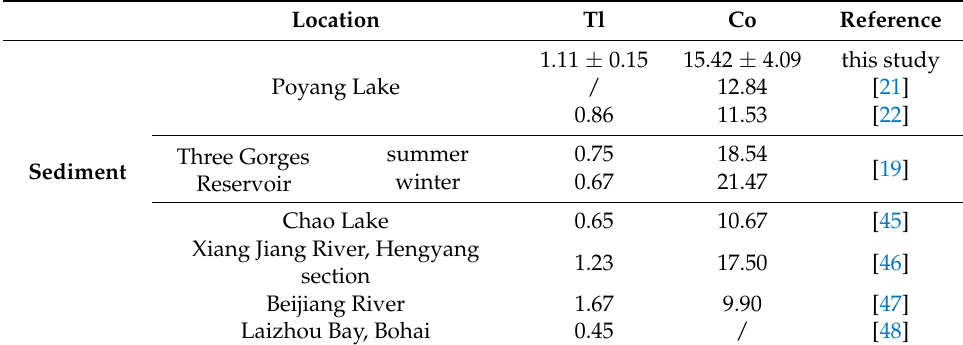
Table 2. Mean concentrations of Tl and Co in other literature (unit: